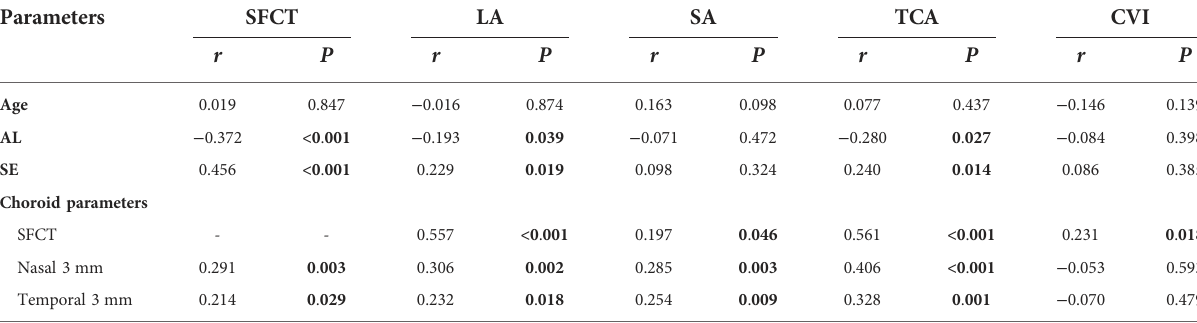
TABLE 4 Correlation analyses between the parameters and choroid microstructure parameters.